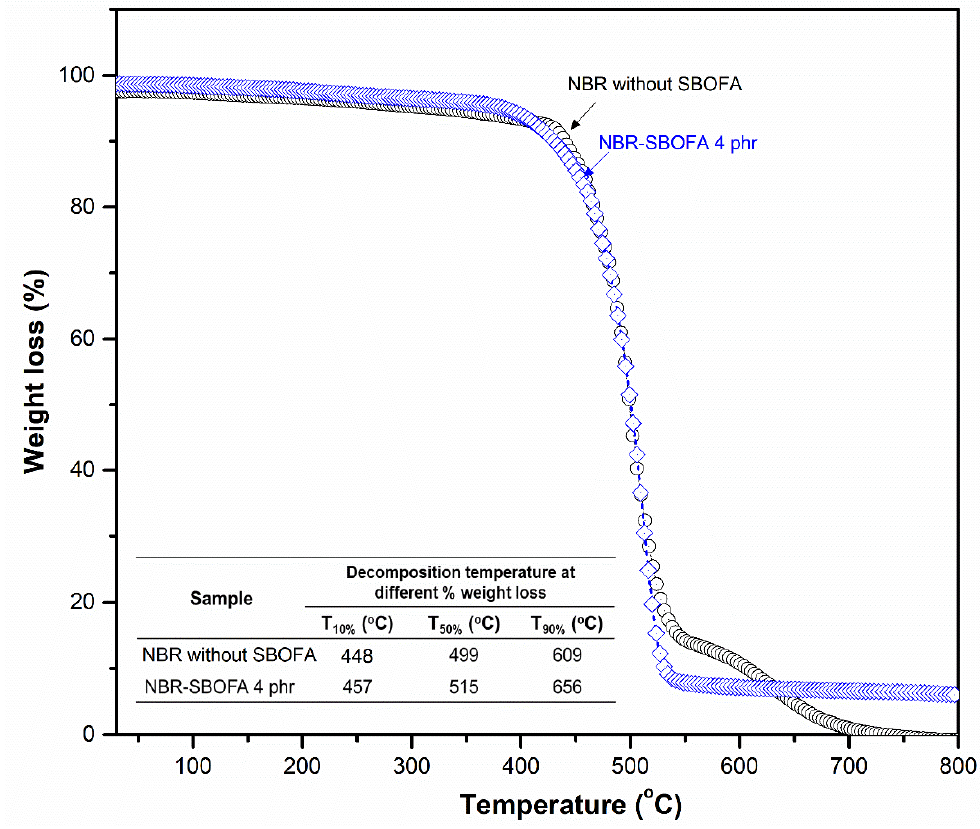
Figure 13. Representative TGA curves of the NBR vulcanizates with SBOFA at 0 and 4 phr . Moreover, it is noteworthy that the stress–temperature curves obtained from the TSSR measurement can be applied to estimate the degree of crosslink density from the initial slope (plateau region; Figure 12a) by applying a modified neo-Hookean equation [38], as shown in Equation (6): 𝜎 (𝑚𝑜𝑙/𝑚 (cid:2871) ) = 𝑣 ∙ 𝑅 ∙ 𝑇 (cid:3437) 𝜆 1 + 𝛼(𝑇 − 𝑇 (cid:2868) ) − (cid:4678) 𝜆 1 + 𝛼(𝑇 − 𝑇 (cid:2868)) (cid:4679) (cid:2879)(cid:2870) (cid:3441) (6) where λ = I / I 0 is the extension ratio and 𝛼 is the thermal expansion coefficient (2.4 × 10 − 4 K − 1 ), and σ and R are the stress and the universal gas constant, respectively. Table 10 summarizes the degree of the crosslink density of the NBR vulcanizates with varying SBOFA loadings based on the TSSR analysis. The crosslink densities of all the vulcanizates obtained from TSSR measurement showed the same trend as those deter- mined by the swelling method (Figure 8). The highest crosslink density (about 211 mol/m 3 ) was found in the NBR with 4 phr SBOFA loading followed by those with SBOFA at 2, 6, and 8 phr at about 169, 157, and 143 mol/m 3 , respectively (Table 10). As a result, it can be concluded that a 4 phr SBOFA loading is the optimal amount to enhance the initial stress and area underneath the relaxation peaks. Thus, these results appear to be relevant to the M H -M L value, level of crosslink density (Figure 8), hardness (Table 6), and the initial stress ( σ 0 ) (Table 10), together with thermal stability of the vulcanizates (Figure 13). 3.7. Comparison of the Effect of SBOFA and DOP on the Properties of NBR Vulcanizates For a long time, DOP has been commercially used as a processing aid for NBR. It is an oily liquid that does not react chemically with rubber, and so can be classified as a physical plasticizer. Due to the requirement to avoid any toxic effect, the aim of this study